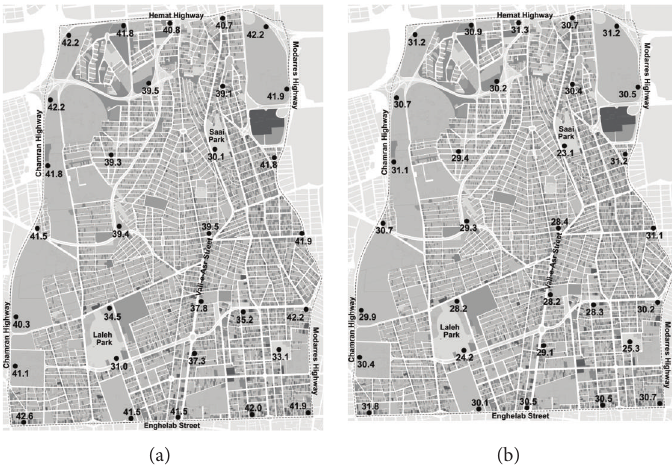
Figure 8: Mobile measurement in 6th urban district on July 18th 2000, (a) 13:00–15:00 h; (b) 21:00–23:00